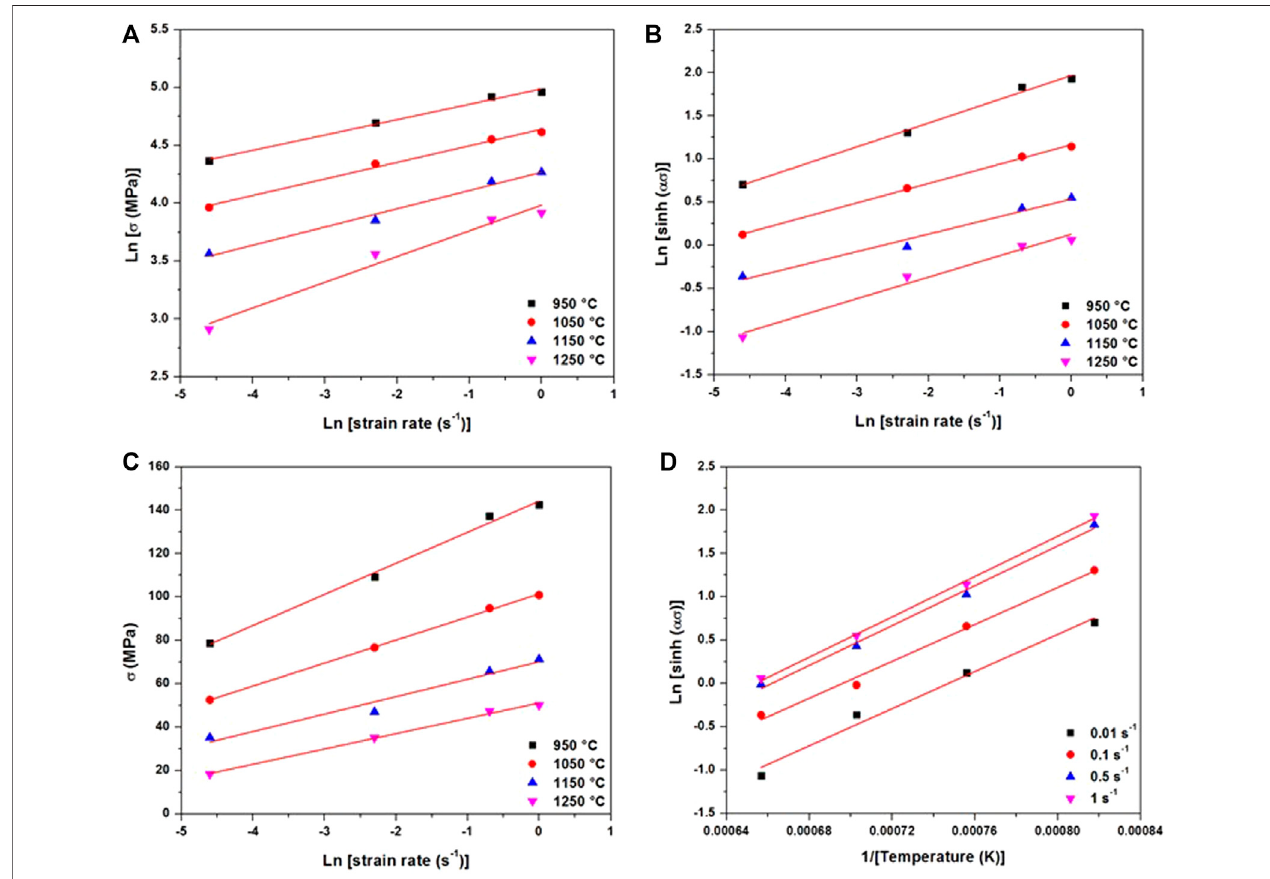
FIGURE 2 | Type of curves used to calculate constants of the hyperbolic sine constitutive equations for strain (cid:1) 0.2.